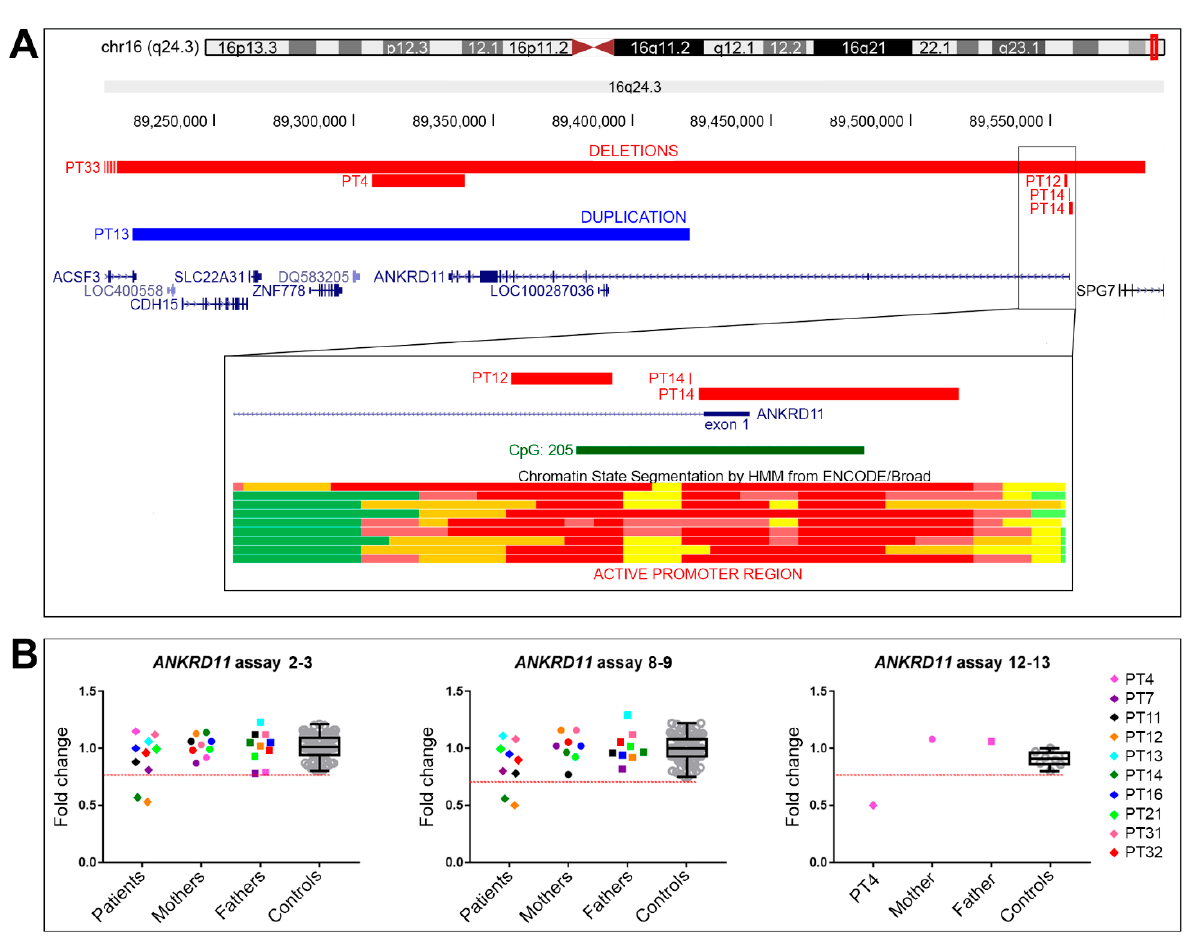
Figure 2. Clinical features of patients PT4 and PT33. ( A , B ) Facial features of PT4 at 3 and 9 years of age. ( C , D ) Frontal and profile facial features of PT33 at age 23 years. ( E ) Secondary dentition of PT33 showing wide upper central incisors (11 mm). ( F ) Foot of PT33 with large hallux. ( G , H ) Small hands of PT33 with hypoplasia of the 1st and 5th metacarpal bones and of the intermediate phalanx of the 2nd finger, bilaterally.